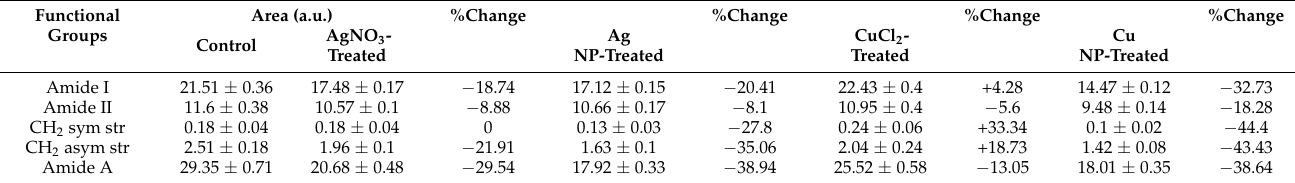
Table 3. Differences in area of peaks between control and treated